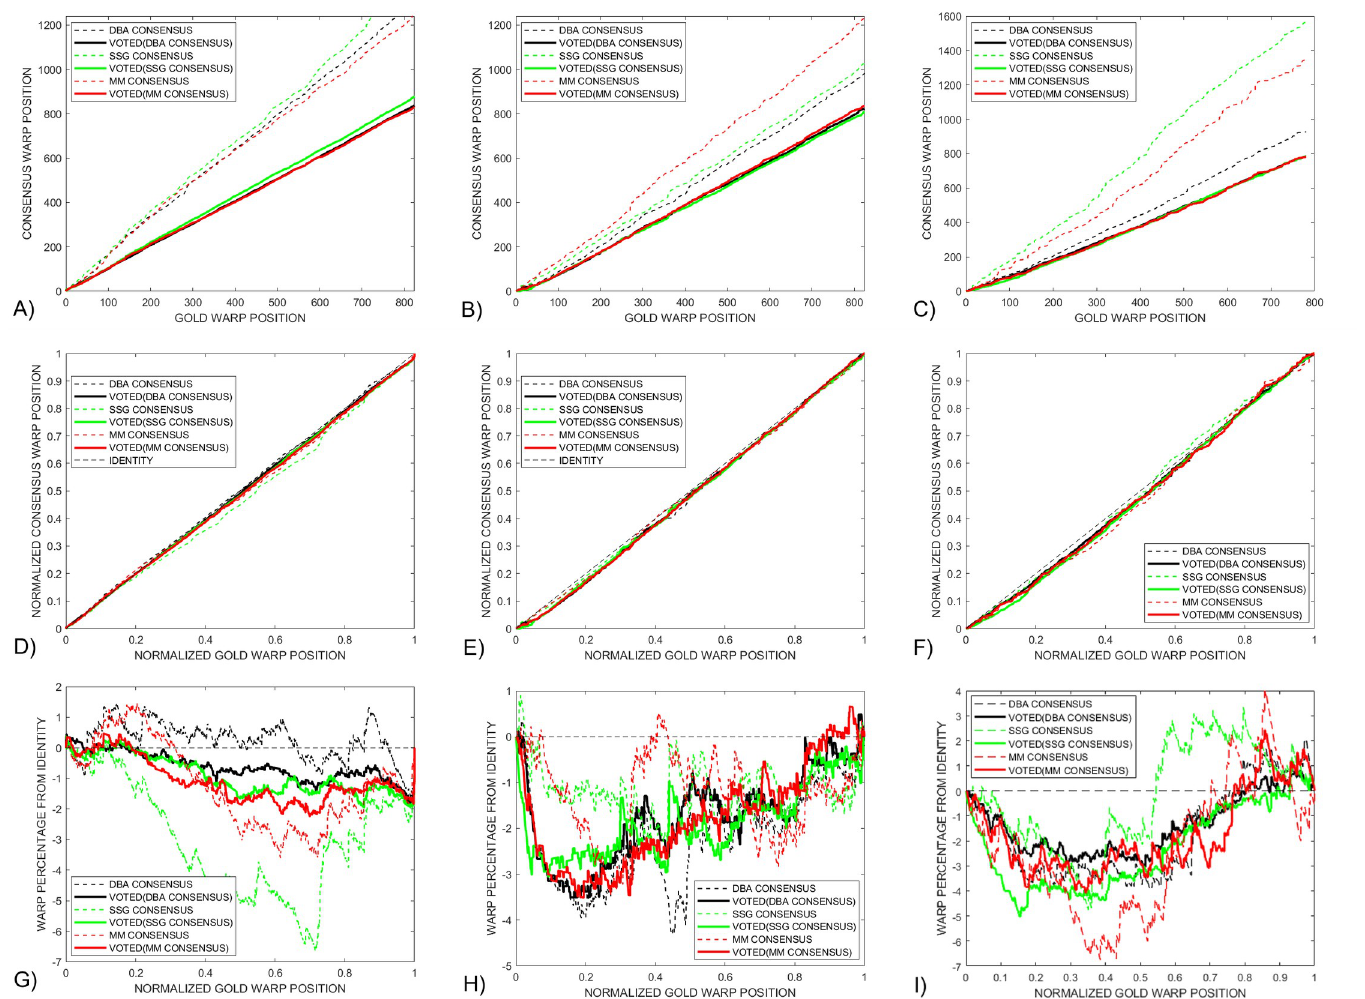
Fig 13. A comparison is made between various warp-path metrics for the Enolase , column1, Sequin R1-71-1 , column 2, and Sequin R2-55-3 , column 3, with normalized warp position calculated from their respective gold lengths. The normal warp path display, Row 1, shows how the DBA , black, SSG , green, and MM , red, signals all gain more similar lengths upon voting. These changes are reflected in the normalized paths, Row 2, which show a drop in deviation from the Identity path after voting. The Difference-from-Identity warp paths, Row 3, shows that the three DTWA consensus signals become similar after